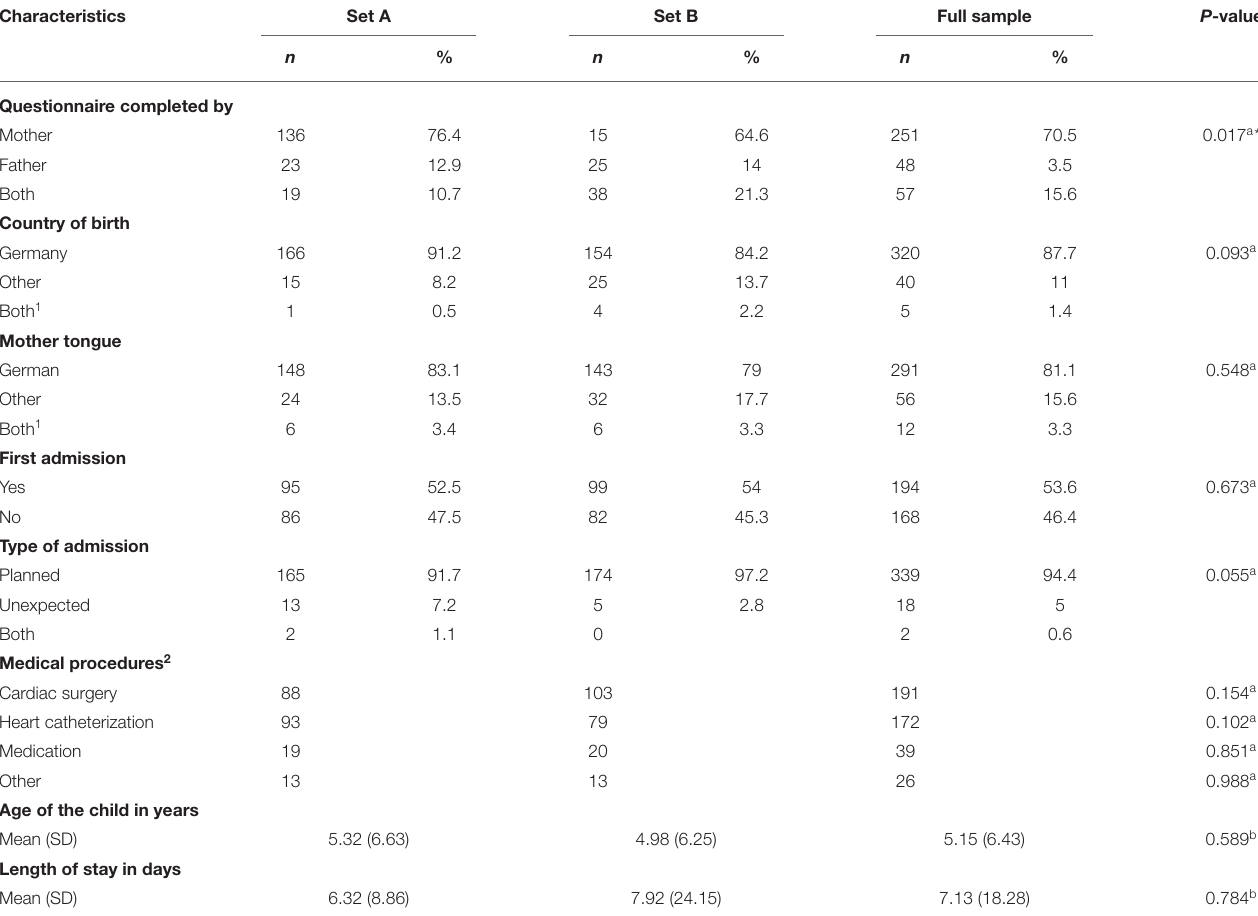
TABLE 1 | Characteristics of children and parents in set A, B, and the full sample.